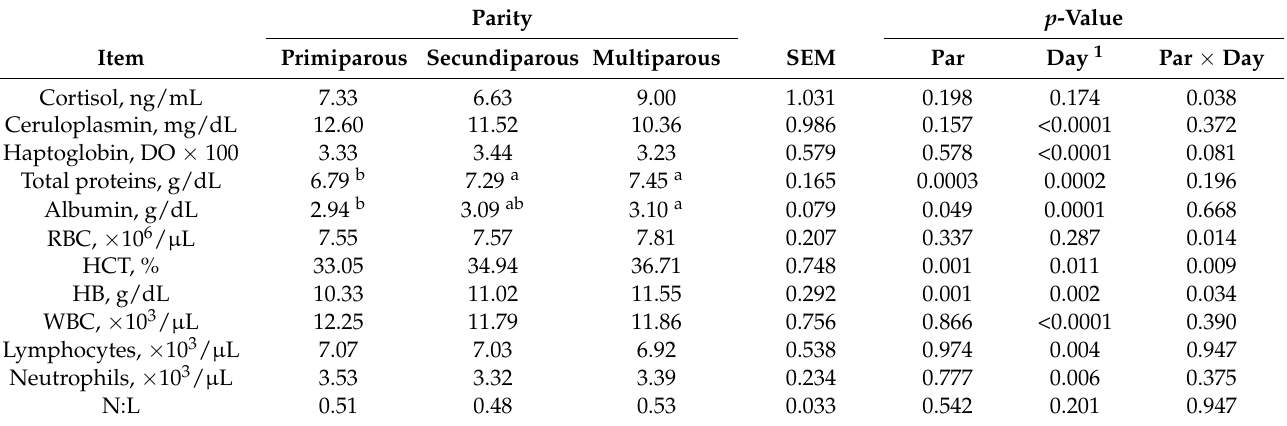
error of means; Par = Parity. 1 Day relative to weaning. a–b Different letters declare significantly different between parities at p <